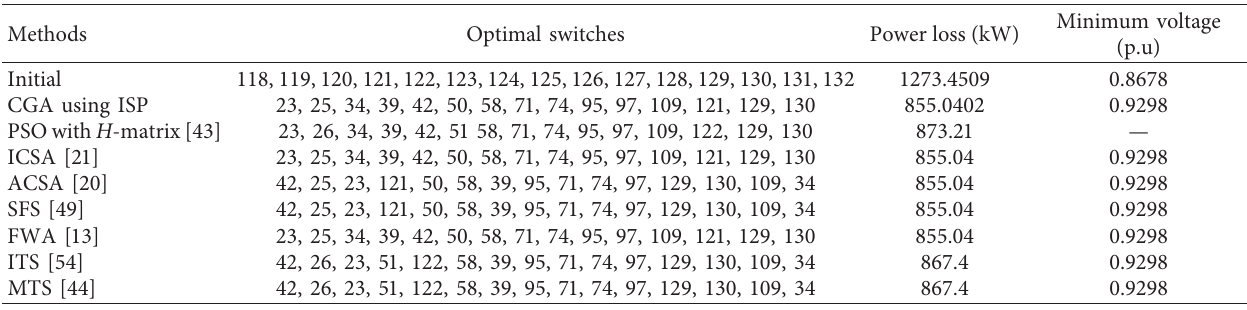
Figure 16: Mean convergence curves of three initialization methods with different population sizes for the 119-node system. Table 9: Comparison results among the proposed method CGA using ISP with other methods for the 119-node system.